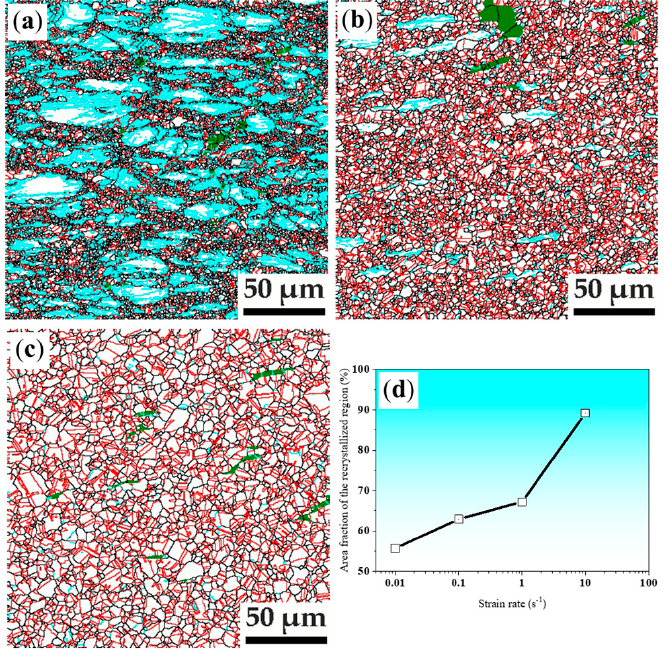
Figure 3. High temperature deformation microstructure revealed by grain boundary maps of specimens compressed at ( a ) 850 °C 1 s − 1 ; ( b ) 950 °C, 1 s − 1 ; ( c ) 1050 °C,1 s − 1 . Black lines present high angle grain boundaries (HAGBs: > 15°), cyan lines represent low-angle grain boundaries (LAGBs: 2–15°), red lines present twin boundaries (TBs), green color present body centered cubic (BCC) phase; ( d ) Area fraction of recrystallized region versus deformation temperature.